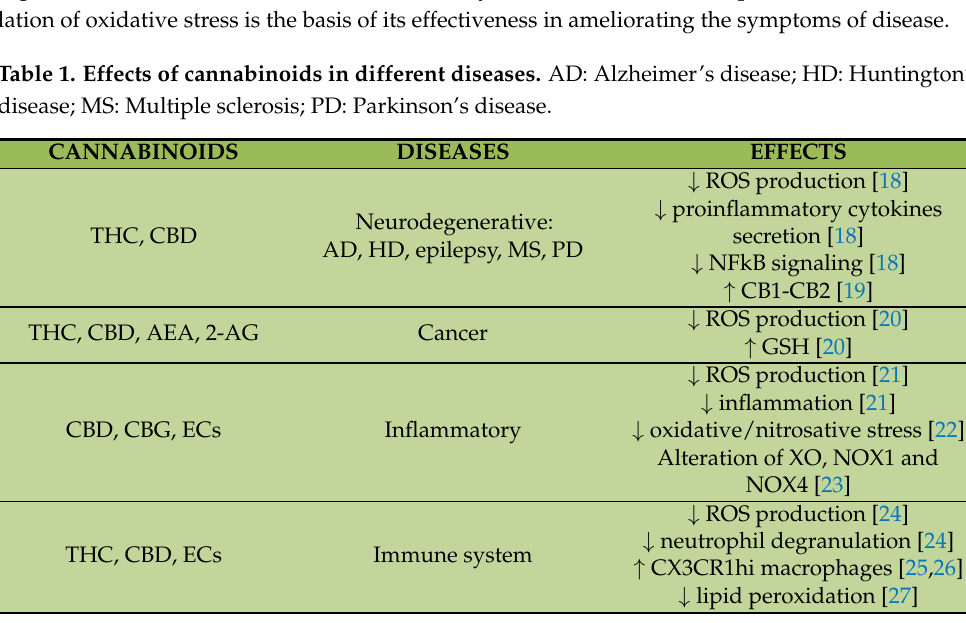
Table 1. Effects of cannabinoids in different diseases. AD: Alzheimer’s disease; HD: Huntington’s disease; MS: Mult iple sclerosis; PD: Parkinson’s disease.